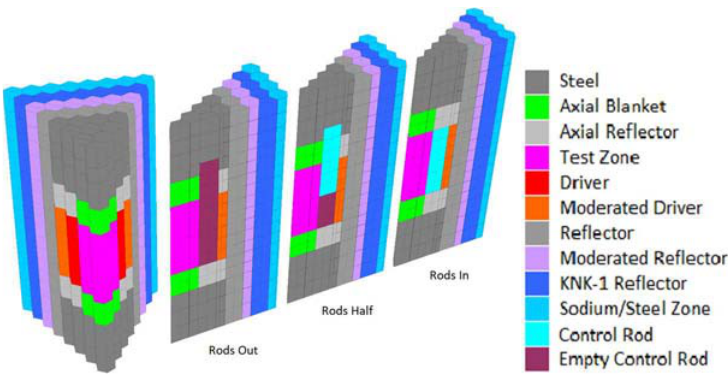
Figure 6. Takeda Benchmark Model Series